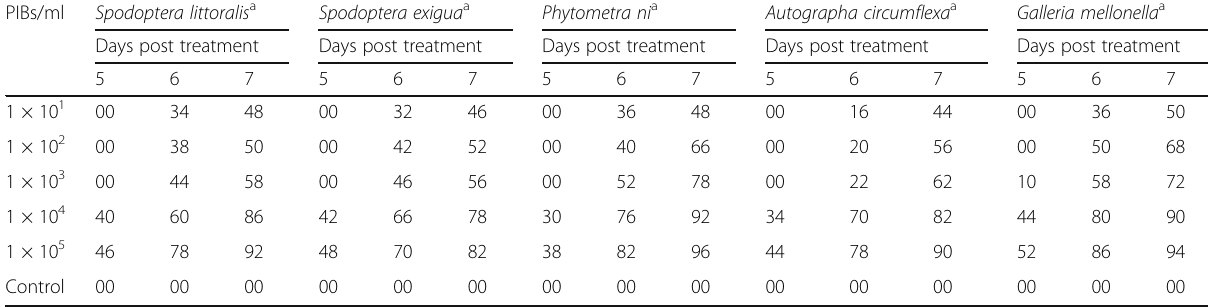
Table 3 Accumulated mortality % in 5 lepidopteran species fed on Spodoptera littoralis nucleopolyhedrosis virus extracted from feces of Labidura riparia fed on diseased larvae